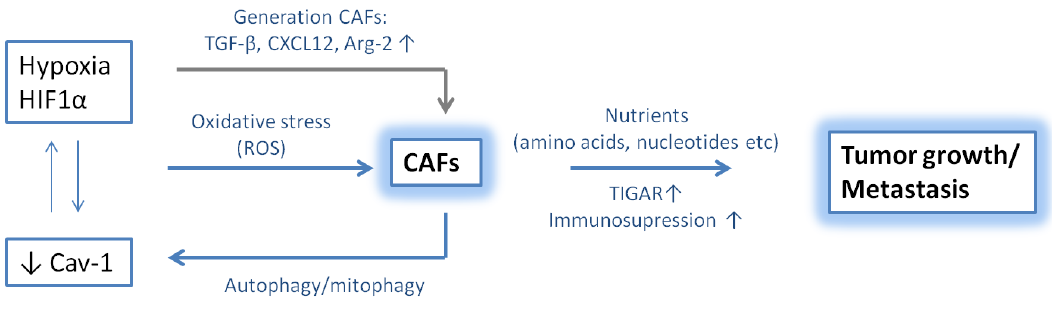
Figure 3. The relation between hypoxia and cancer associated